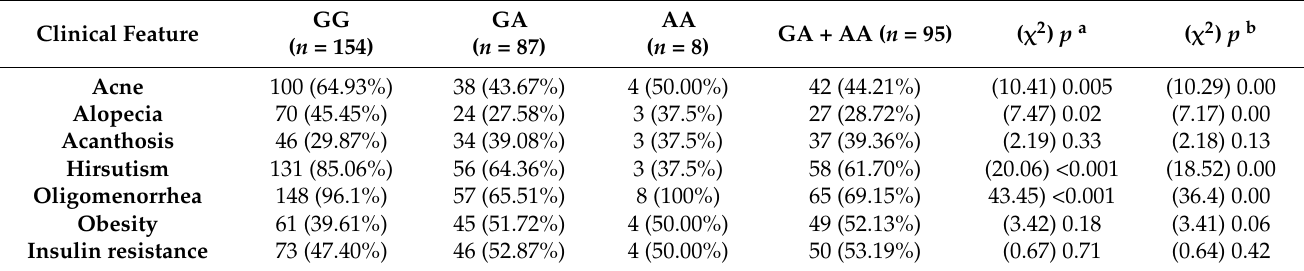
Table 5. Genotypic–phenotypic association of clinical symptoms of hyperandrogenism, oligo- anovulation and insulin resistance in IRS-1 Gly972Arg genotypes in PCOS women.